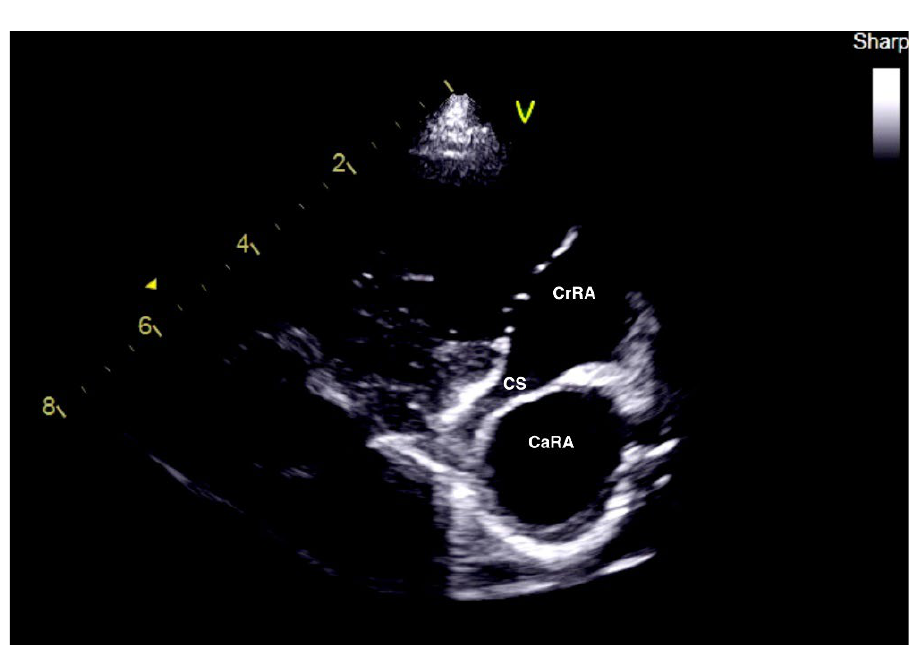
Figure 4. Two-dimensional echocardiographic images of case 2. Right parasternal oblique view focused on the right atrium and caudal vena cava (Figure 1B) showing the right atrium divided by a membrane in two chambers: the caudal chamber (CaRA) and cranial chamber (CrRA). Differently to case 1, the coronary sinus (CS) entered the CrRA. CaRA: caudal right atrium chamber; CrRA: cranial right atrium chamber; CS: coronary sinus.